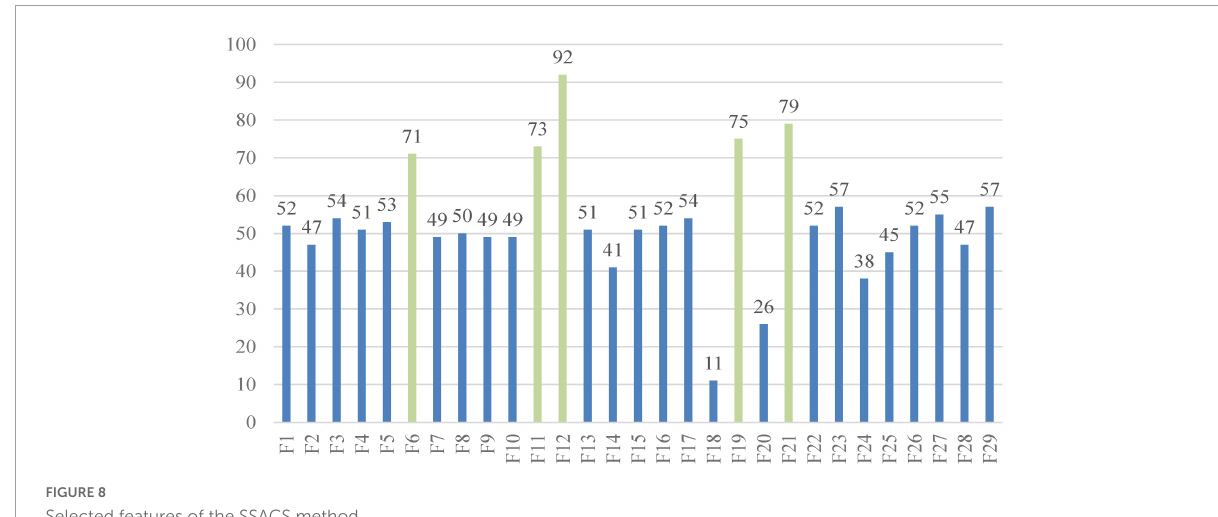
FIGURE8 Selected features of the SSACS